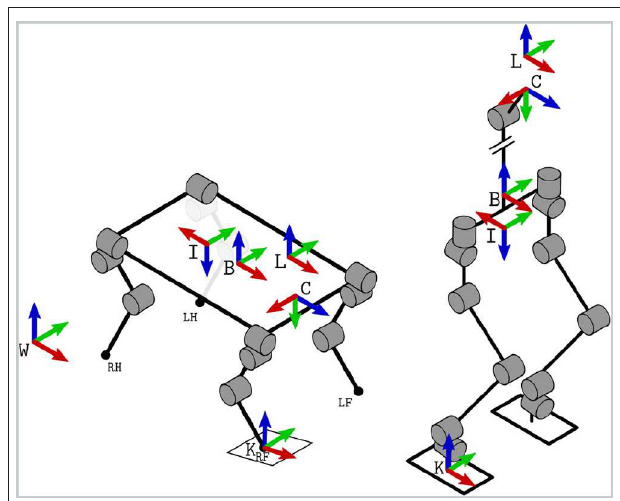
FIGURE 2 | Reference frame conventions for typical quadruped and humanoid robots (with a simplified upper torso structure). The world frame W is fixed to earth, while the base frame B , the camera’s optical frame C , and the IMU frame I are rigidly attached to the robot’s chassis or head. When a foot touches the ground (e.g., the Right Front, RF), a contact frame K (perpendicular to the ground) is